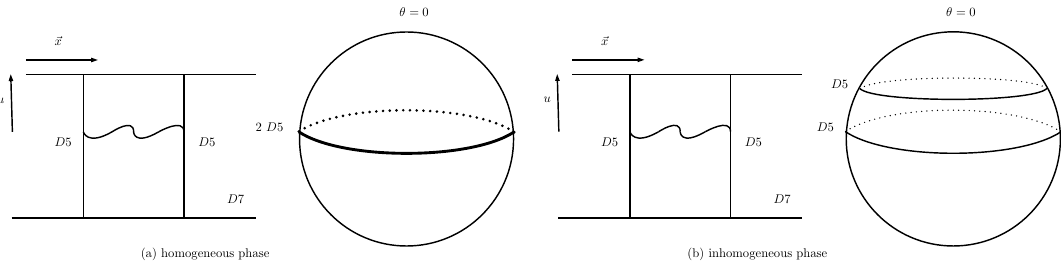
Figure 7 . Phases of the top-down model: (a) The homogeneous phase is described by the two D5 branes wrapping the S 4 S 5 at the same polar angle. The charge quantization condition (4.5) (cid:26) then implies that the number density is the same on both defects. (b) In the inhomogeneous phase, the branes wrap di(cid:11)erent angles on the S 5 , corresponding to a di(cid:11)erence in charge density. The D5 branes wrapping angles close to the equation corresponds to half